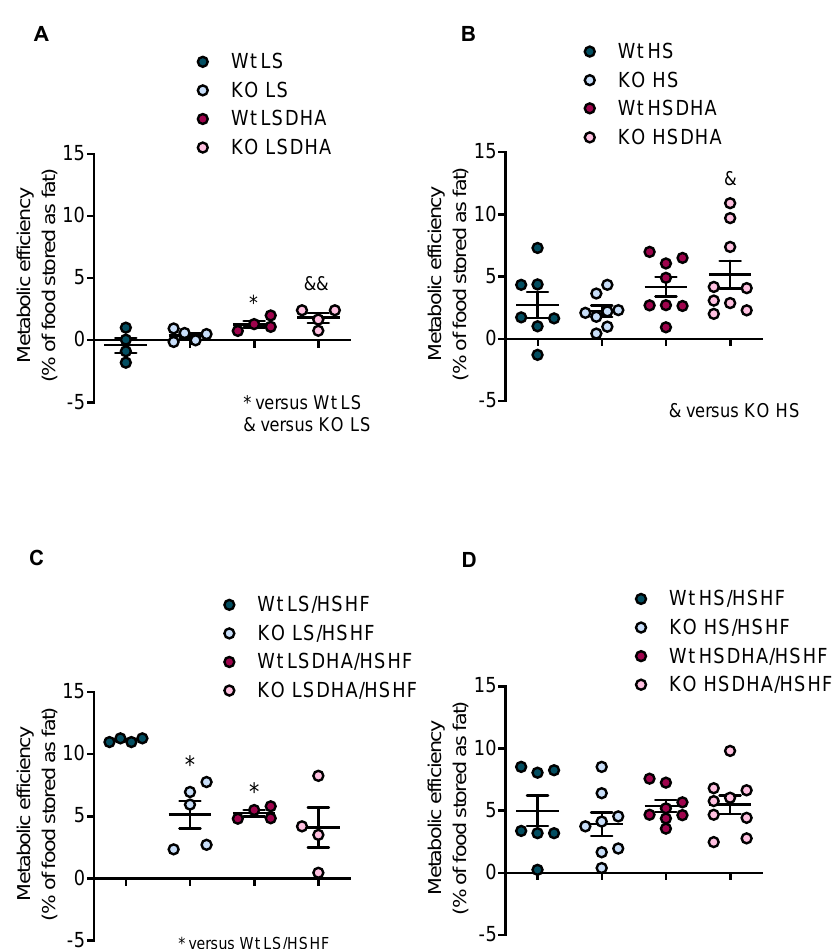
Figure 5. High dietary sucrose content and DHA supplementation improves metabolic efficiency of Elovl2 -/- mice. ( A ) Metabolic efficiency, presented as % food stored as fat, in wild-type and Elovl2 -/- mice after feeding low-sucrose diet (LS) or low-sucrose DHA-enriched diet (LSDHA). ( B ) Metabolic efficiency after feeding high-sucrose (HS) or high-sucrose DHA-enriched diet (HSDHA). ( C ) Metabolic efficiency after feeding of high-sucrose, high-fat diet (HSHF) in animals pre-treated with low-sucrose diet (LS) or low-sucrose DHA-enriched diet (LSDHA). ( D ) Metabolic efficiency after feeding of high-sucrose, high-fat diet (HSHF) in animals pre-treated with high-sucrose (HS) or high-sucrose DHA-enriched diet (HSDHA). Results shown are means of 4 – 9 mice ± SEM. & P < 0.05 and && P < 0.01. * P < 0.05.